Question: What form of chart is displayed?
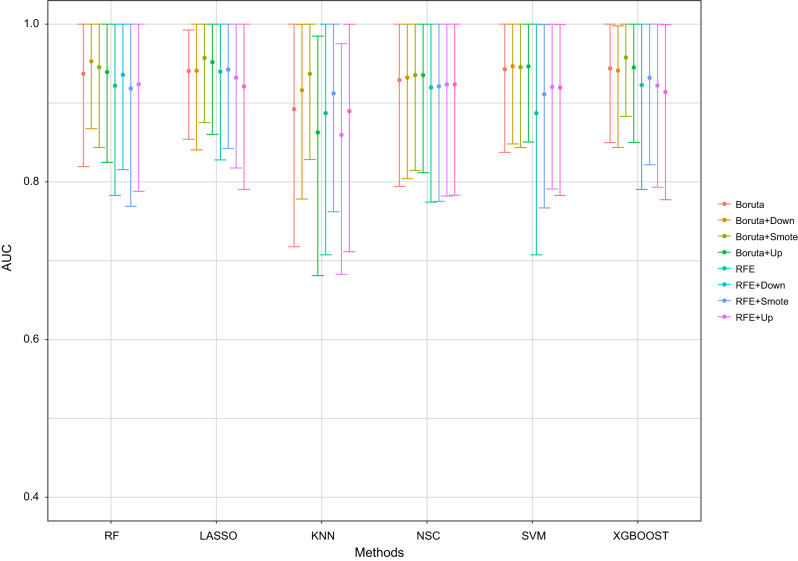
Answer: bar